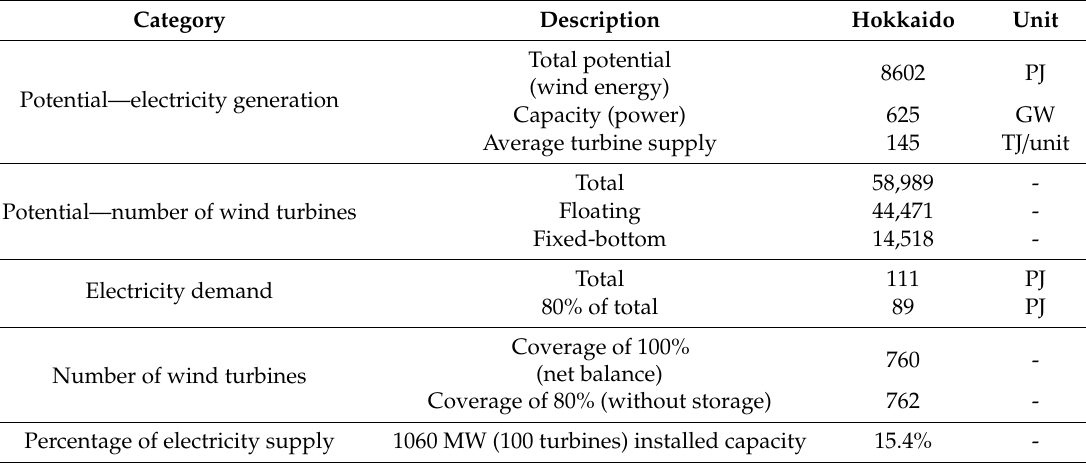
Table 5. Overview of the electricity supply and demand scenario in